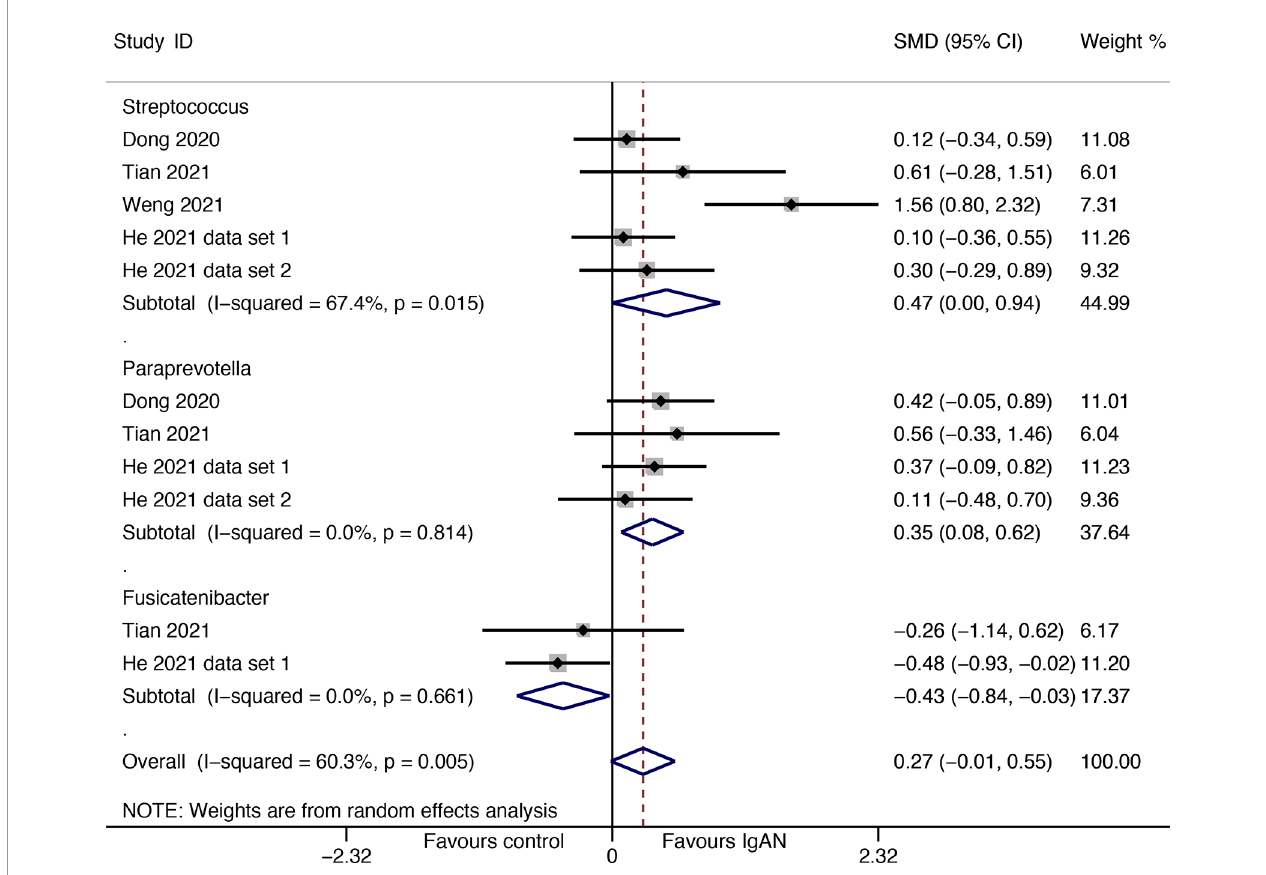
FIGURE 5 | Forest plot for differences in gut fl ora between patients with IgAN and healthy